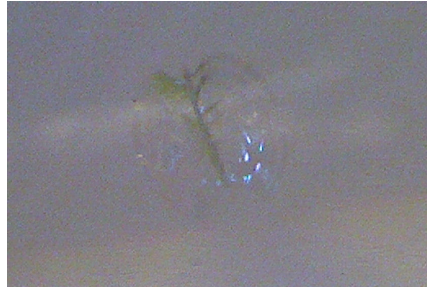
Figure 11: Weibull plot of slow and fast tests on indented specimens.